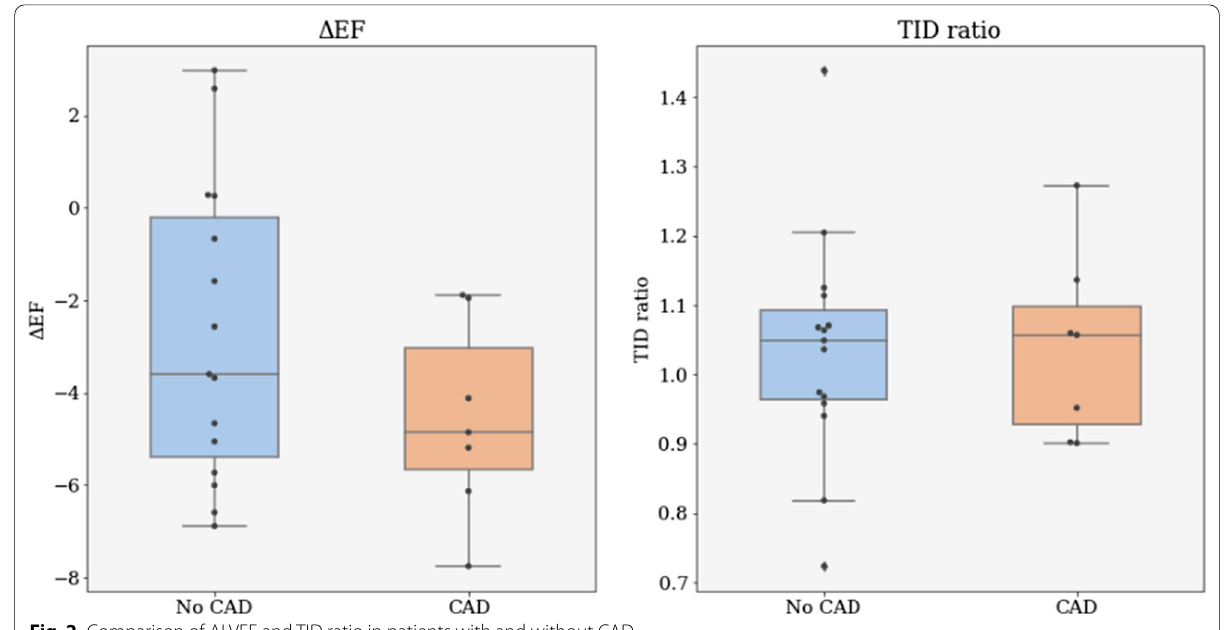
Fig. 2 Comparison of ΔLVEF and TID ratio in patients with and without